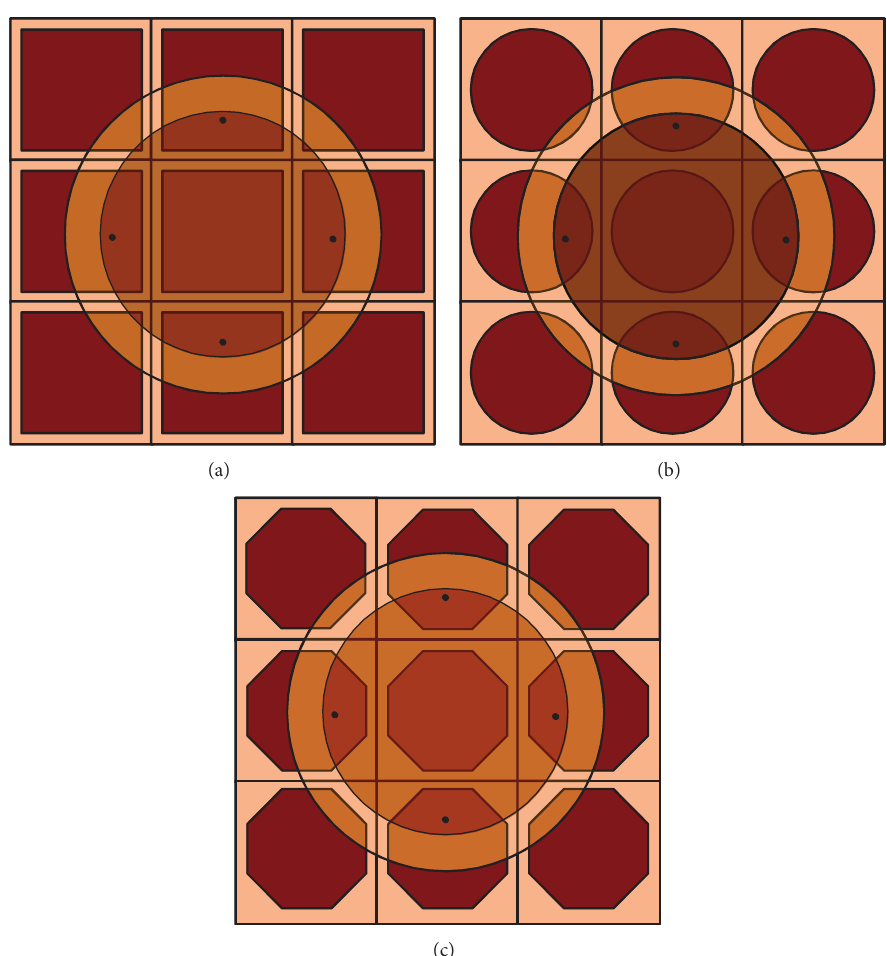
Figure 6: The geometry of the circular microstrip patch antenna with AMC structures. (a) Model-S. (b) Model-C. (c) Model-O.